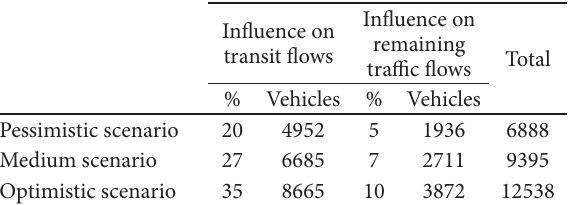
Table 4. Evaluation of the influence of charged entrance or road